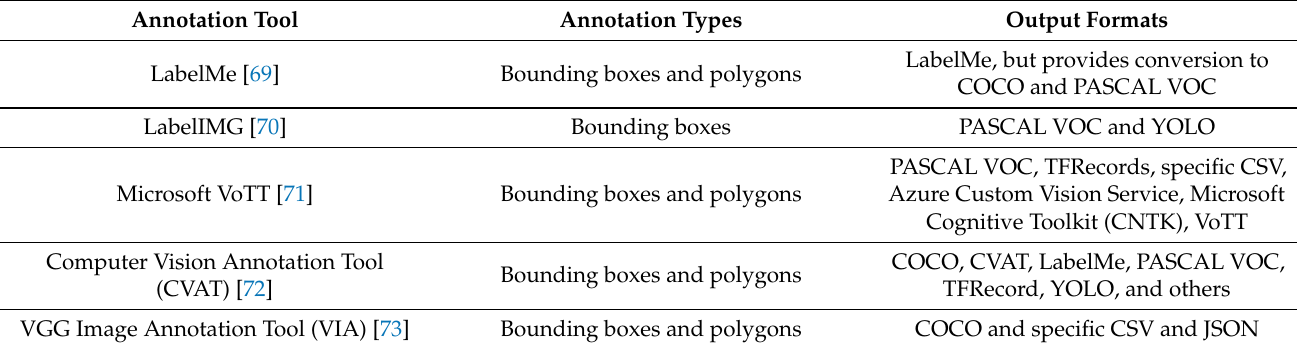
Table 1. Popular free annotation tools and their supported output